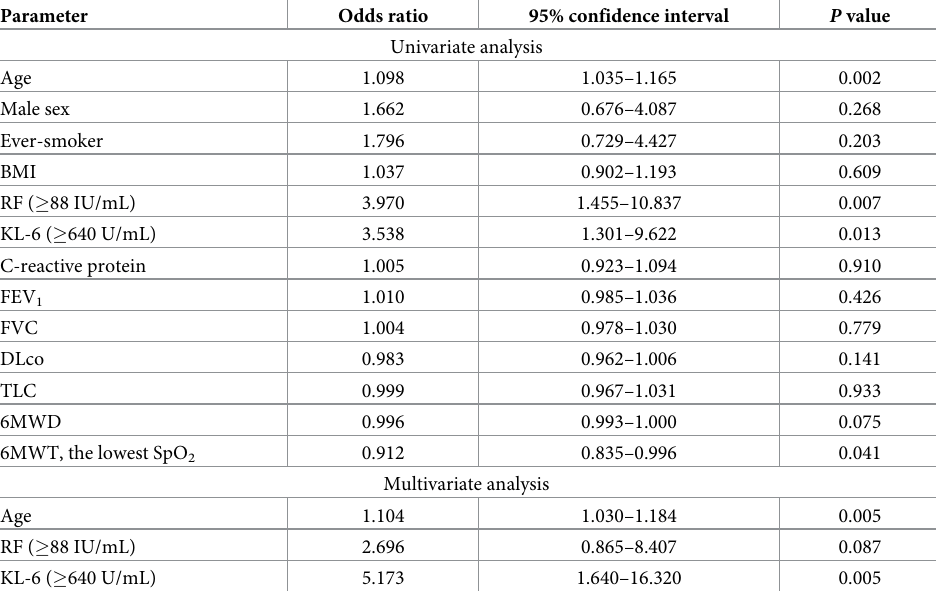
UIP, usual interstitial pneumonia; RA, rheumatoid arthritis; ILD, interstitial lung disease; BMI, body mass index; RF, rheumatoid factor; KL-6, Krebs von den Lungen-6; FEV 1 , forced expiratory volume in 1 second; FVC, forced vital capacity; DLco, diffusing capacity for carbon monoxide; TLC, total lung capacity; 6MWD, 6-minute walk test distance; 6MWT, 6-minute walk test; SpO 2 , peripheral oxygen saturation Among the covariates significant in the univariate analysis, 6MWT, the lowest SpO 2 was not included in the multivariate analysis because of high correlation with DLco (r = 0.733, P < 0.001) poor prognosis (hazard ratio [HR], 2.984; 95% CI, 1.227–7.257; P = 0.016); In addition, older age, male sex, lower FVC, and a UIP pattern were also independently associated with poor prognosis. When radiological honeycombing ( � 5% of total lung extent) was included in the multivariate model instead of a UIP pattern, a high KL-6 level was also an independent prog- nostic factor (HR 3.235, 95% CI, 1.394–7.510, p = 0.006) along with age (HR 1.096, 95% CI